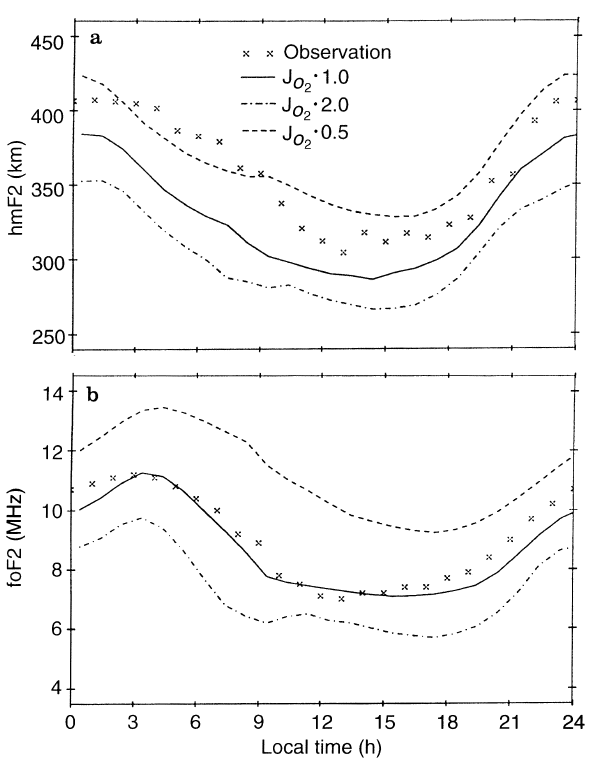
Fig. 11a,b. The sensitivity of a hmF2 and b f oF2, over Argentine Islands, to changes in the magnitude of the O 2